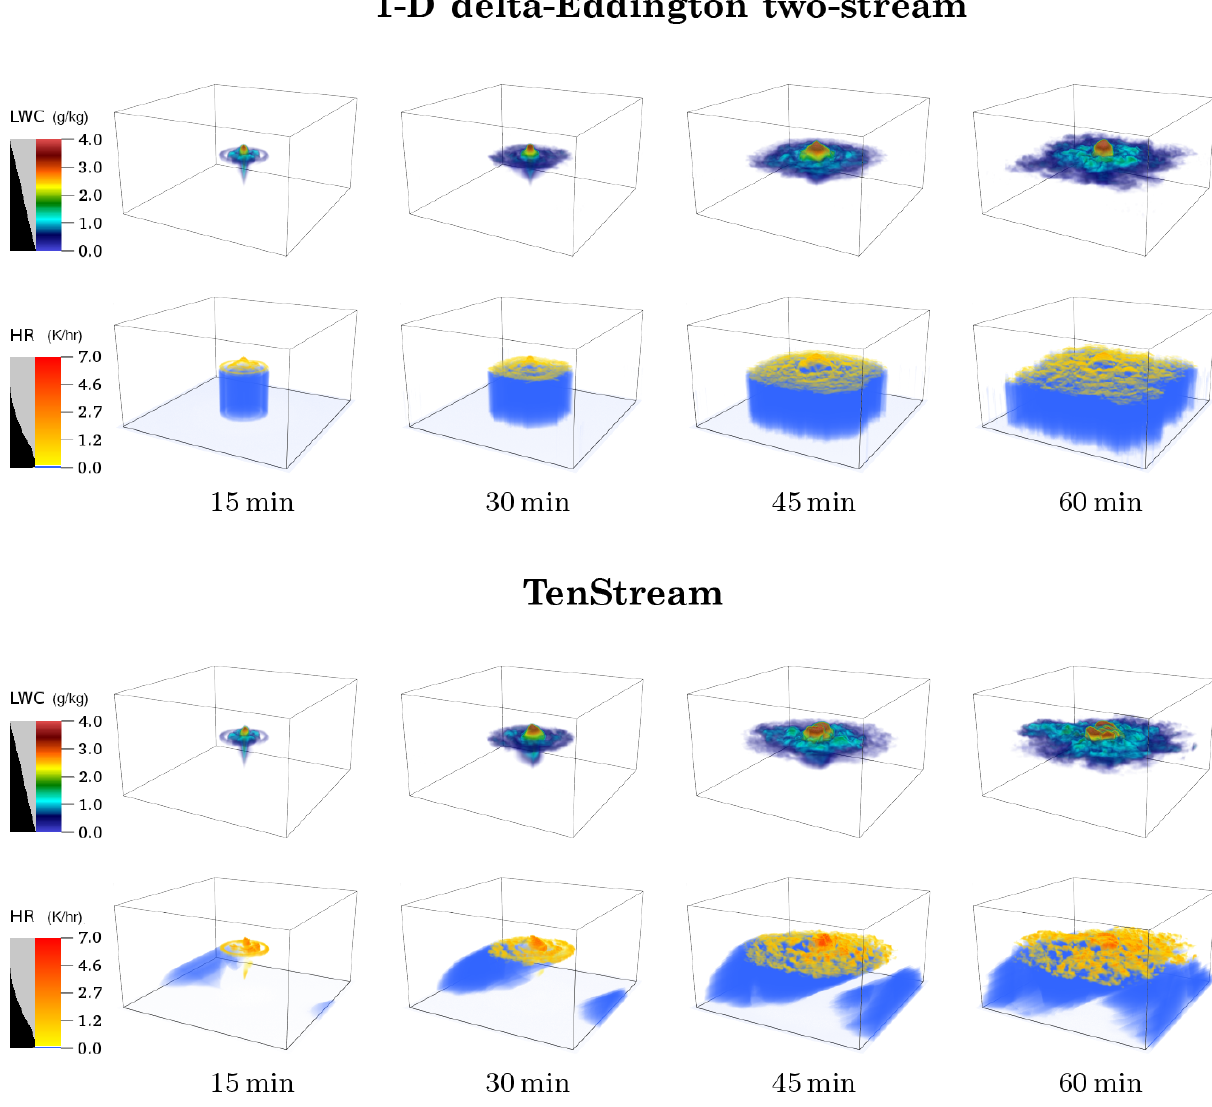
Figure 2. Volume-rendered perspective on liquid water content and solar atmospheric heating rates of the warm-bubble experiment (initial- ized without horizontal wind). The two upper panels depict a simulation which was driven by 1-D radiative transfer and the two lower panels show a simulation where radiative transfer is computed with the TenStream solver (solar zenith angle θ = 60 ◦ ; constant surface fluxes). Three-dimensional effects in atmospheric heating rates introduce anisotropy which in turn has feedback on cloud evolution. Domain dimen- sions are 12.8 × 12.8km horizontally and 5km vertically at a resolution of 50m in each direction. See Sect. 6 for simulation parameters. Gray bar in the legend determines the transparency of the individual colors for the volume